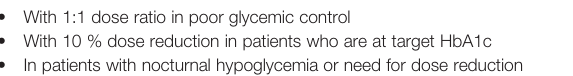
TABLE 6 | Expert Panel Recommendation 6: Switching from premixed insulins. (cid:129) With 1:1 dose ratio in poor glycemic control (cid:129) With 10 % dose reduction in patients who are at target HbA1c (cid:129) In patients with nocturnal hypoglycemia or need for dose